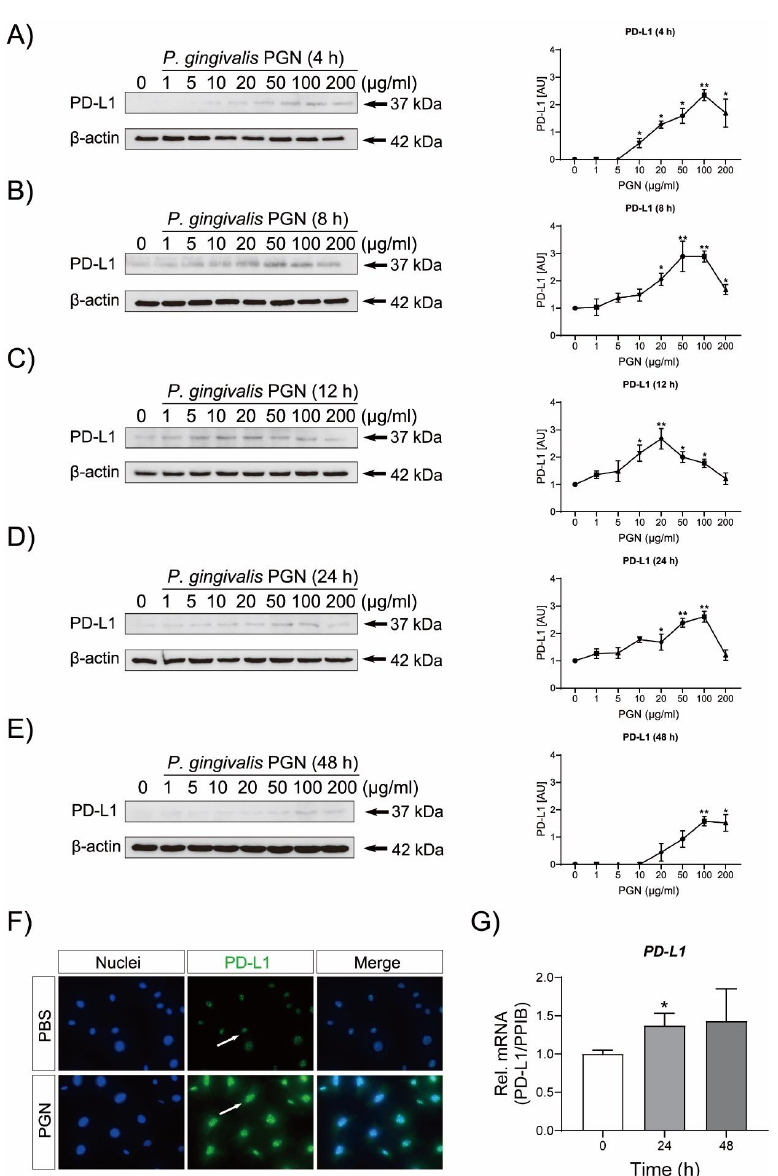
Figure 1. Kinetics of PD-L1 expression in OCCM-30 cells 4, 8, 12, 24 and 48 h after infection with P. gingivalis PGN. OCCM-30 cells were stimulated with P. gingivalis PGN (1, 5, 10, 20, 50, 100 and 200 μg /mL) for the indicated time periods (4, 8, 12, 24 and 48 h). ( A – E ) Western blotting images show the PD-L1 protein expression in the unstimulated cells and OCCM-30 cells infected by P. gingivalis PGN. The PD-L1 levels were normalized by comparing them to the levels of β -actin. The representative bands from three independent experiments are shown. P. gingivalis PGN up- regulated PD-L1 expression is shown in comparison to the non-stimulated control group. ( F ) The PD-L1 fluorescent pictures by immunofluorescence staining showed the expression of the immune check point PD-L1 (green) in P. gingivalis PGN-treated OCCM-30 cells after 24 h. The white arrow points the PD-L1 that was increased after the hypoxic incubation. Nuclei are stained with DAPI (blue). Individual and merged images of PD-L1 and DAPI are shown. ( G ) Quantitative RT-qPCR analysis was performed to examine the gene expression of PD-L1 in cementoblasts stimulated with P. gingivalis PGN. The relative mRNA expression of PD-L1 was obtained through normalizing to internal PPIB . The statistical significance was determined by student t -test (n = 3 for every group). PD-L1 protein expression from unstimulated cells was arbitrarily set as 1; the error bars show standard deviations (SD). Data are represented as mean ± SD. (* p < 0.05; ** p <